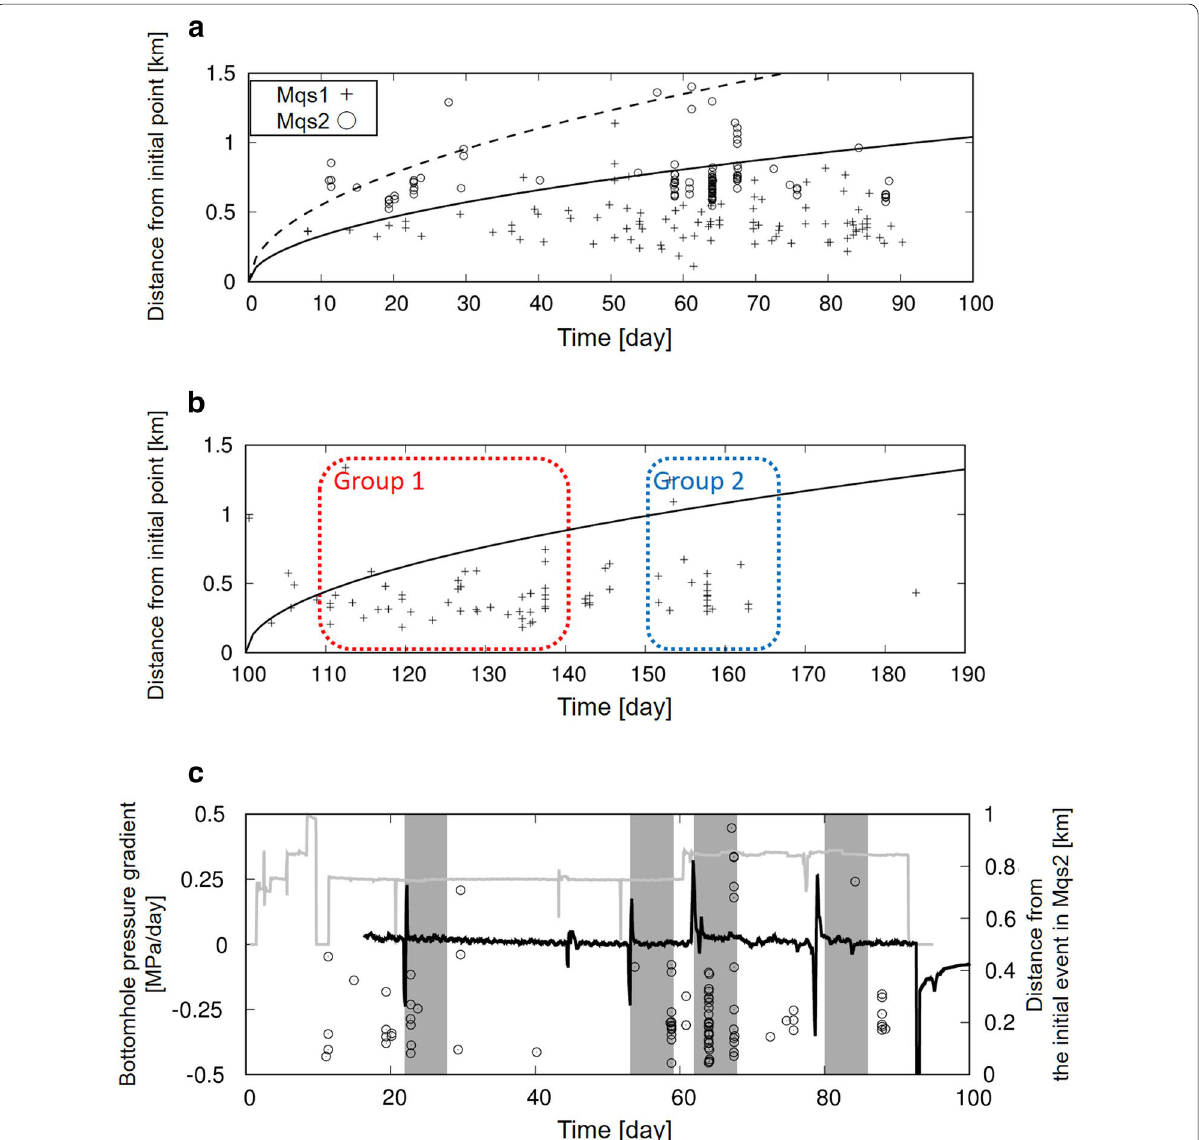
Fig. 3 Spatiotemporal distribution of microseismic events. a Results for Mqs1 and 2. The solid and dashed lines show diffusion curves for Mqs1 and 2; b results for Mqs3 with a diffusion curve. Groups 1 and 2 correspond to the groups of microseismic events shown in Fig. 4d. The horizontal axis shows days from the start of injection; the vertical axis shows distance from the initial point; c temporal relationship between Mqs2 and pressure change rate at the bottom of the Test Well. The black line shows the pressure change rate (left vertical axis), and the circles show the spatiotemporal distribution of the microseismic events (right vertical axis). The length of the shaded areas is 7 days. Gray line represents injection rate in Fig.